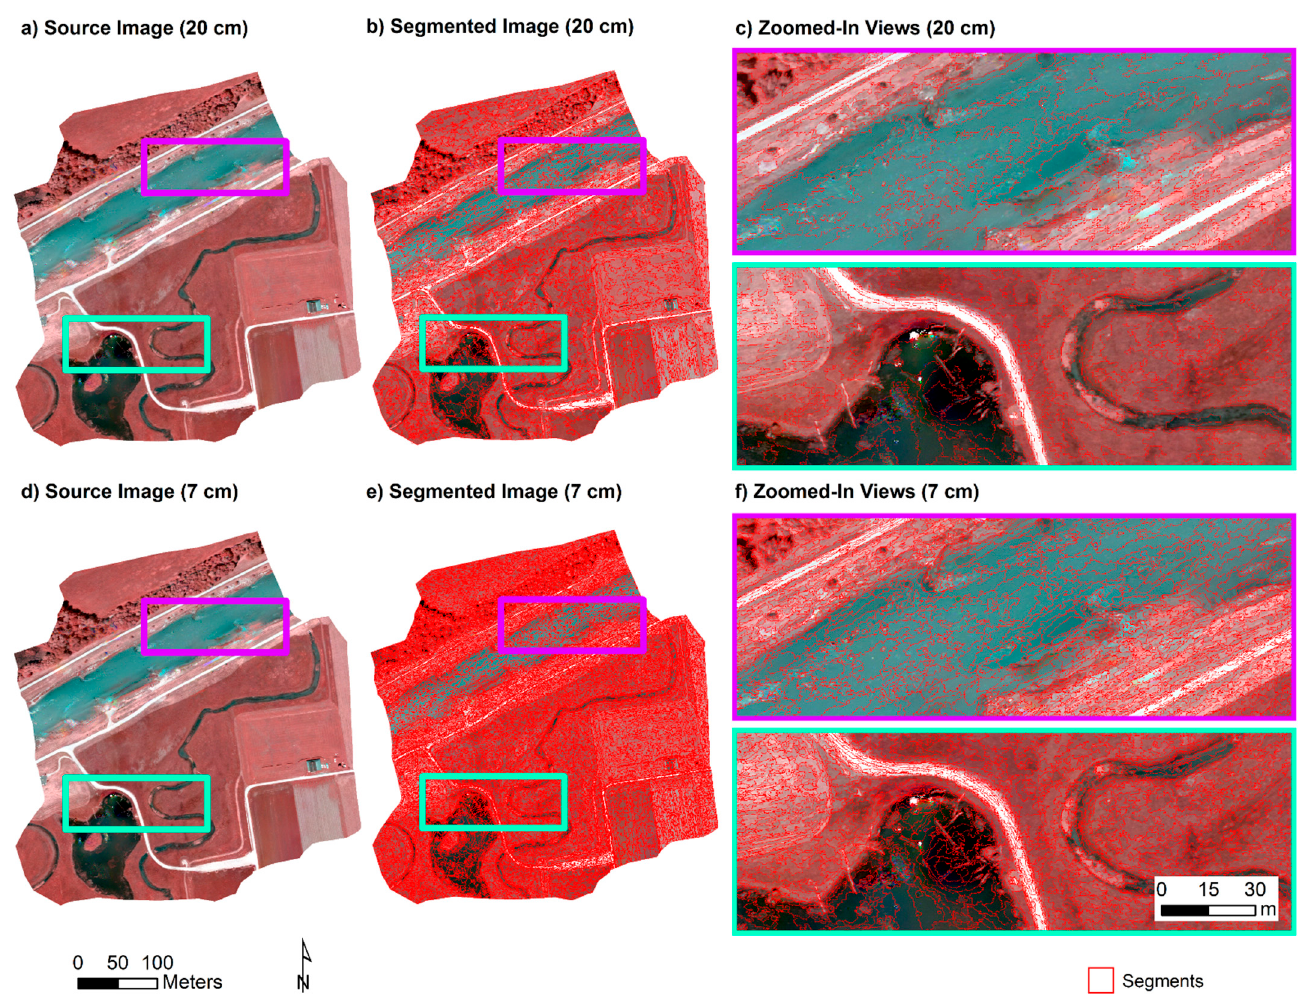
Figure 4. ( a ) Narrow-band image from 22 June 2016 of the River Gail study area with 20 cm pixel size (bands 797, 670, and 550 nm as R,G,B); ( b ) Image segments generated using eCognition ® for the 20 cm narrow-band image; ( c ) Zoomed-in views to the source image and segments depicted by the purple and cyan rectangles in ( a ) and ( b ); ( d ) Narrow-band image from 22 June 2016 of the River Gail study area with 7 cm pixel size; ( e ) Image segments generated using eCognition ® for the 7 cm narrow-band image; ( f ) Zoomed-in views to the source image and segments depicted by the purple and cyan rectangles in ( d ) and ( e ).